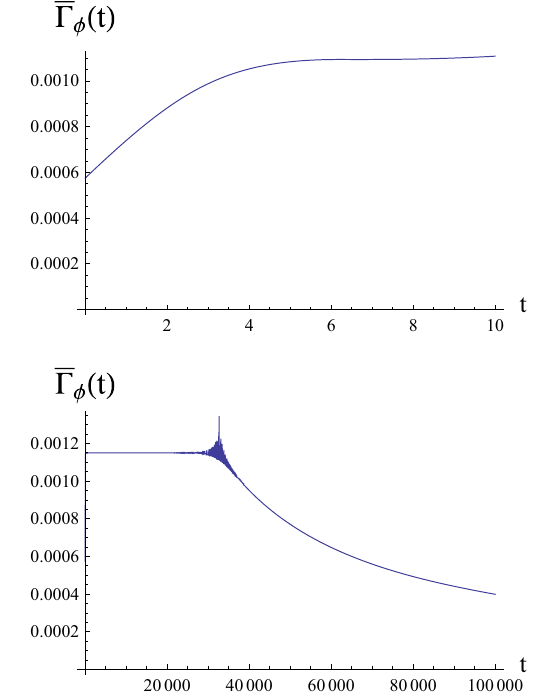
Fig. 2 The dependence ¯ Γ φ ( t ) for the best fit values (see Table 1). The upper panel presents the evolution of ¯ Γ φ ( t ) for the early Universe and the present epoch. The lower panel presents evolution of ¯ Γ φ ( t ) for the late time Universe. The cosmological time t is expressed in s × Mpc these units, the age of the Universe is equal 1.41 s × Mpc